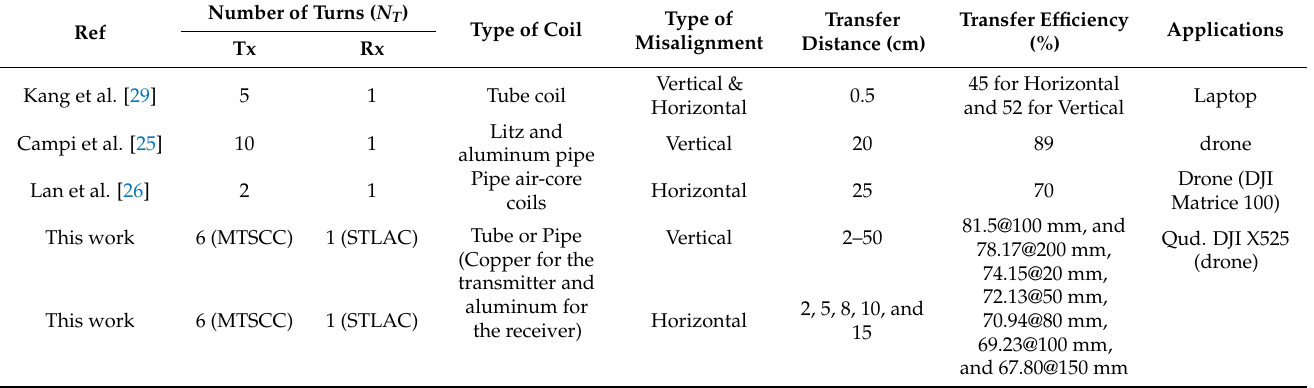
Table 7. Comparison between the proposed coils method at various vertical alignment and lateral misalignment conditions with previous